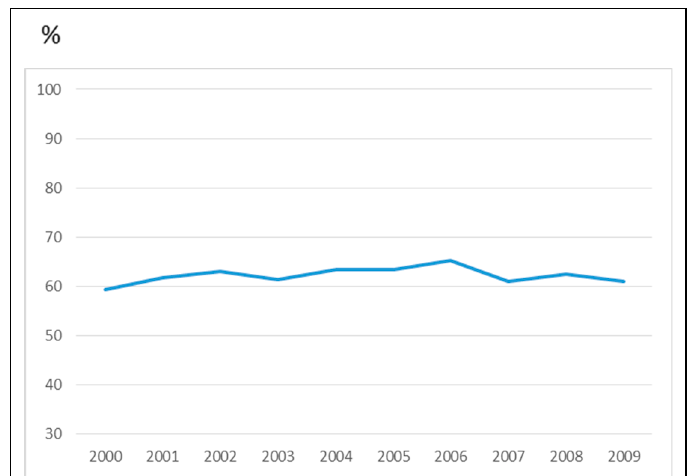
Figure 2. Percentages of visual fatigue in terms of years.